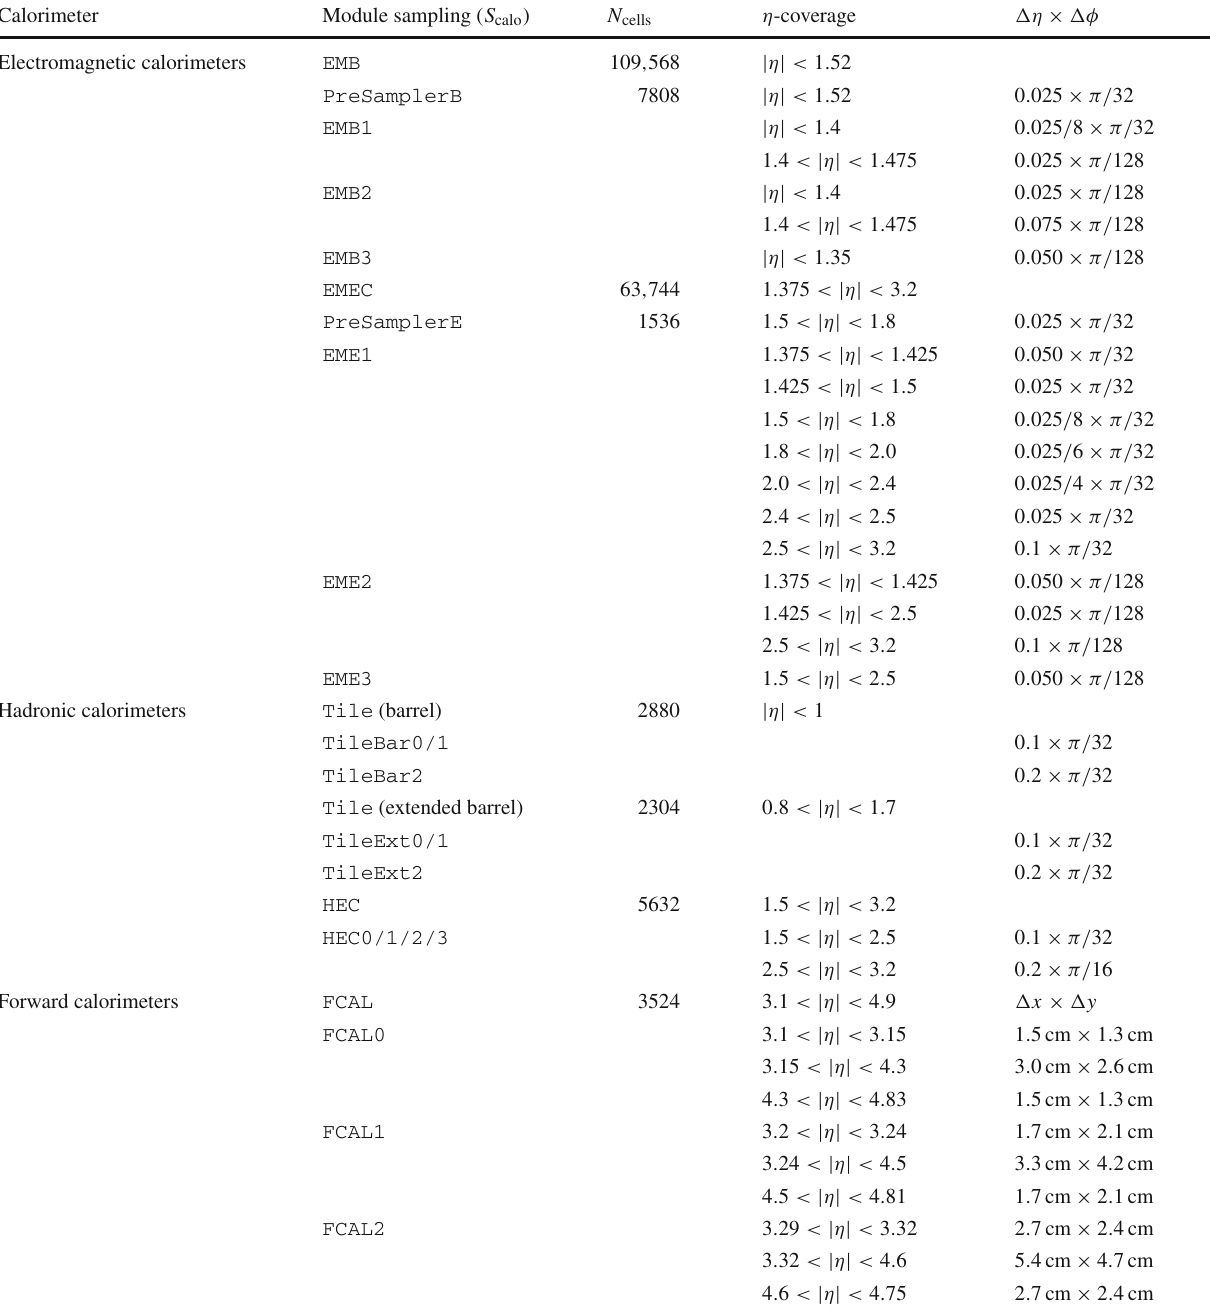
FCAL granularity is approximately (cid:9)η × (cid:9)φ = 0 . 15 × 0 . 15 ( 0 . 3 × 0 . 3 ) at η = 3 . 5 ( 4 . 5 ) . The total number of read-out cells, including both ends of the calorimeter system, with (without) pre-samplers is 187652